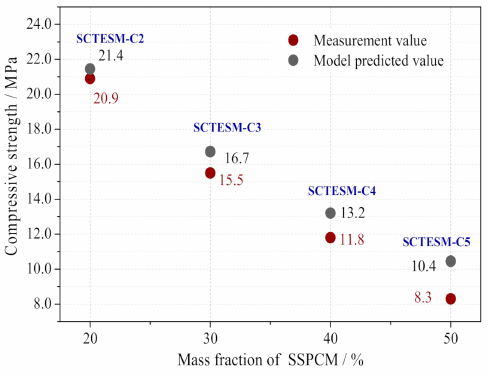
Figure 18. Compressive strength measurements versus model predicted